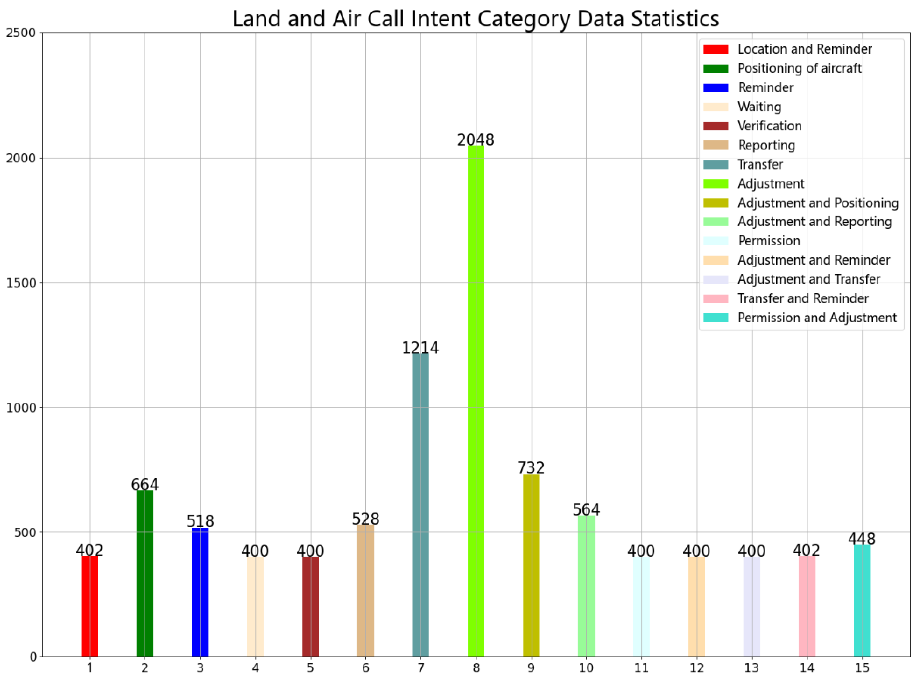
Figure 8. Label distribution of dataset.